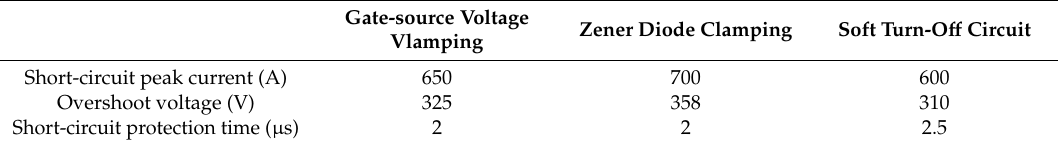
Table 2. Test data of short circuit protection under di ff erent